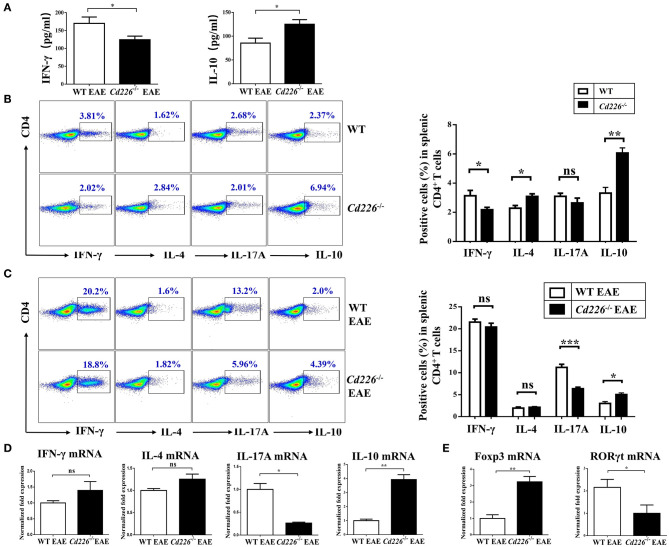
Lower levels of Th17 cells and higher levels of Tregs were observed in the spleen of Cd226−/− EAE mice. (A) The plasma levels of IFN-γ and IL-10 in Cd226−/− and WT mice during EAE pathogenesis were assessed by ELISA (n = 8). (B) Protein expression of IFN-γ, IL-4, IL-17A and IL-10 in sorted CD4+ T cells from splenocytes in Cd226−/− mice and WT littermates was assessed by intracellular staining. The numbers in each quadrant show the percentage of the relevant cell population (n = 8). (C) Splenocytes were stimulated in vitro with PMA (phorbol myristate acetate), ionomycin and brefeldin A in 10% FBS/RPMI 1,640 for 6 h. FCM data analysis of CD4+ T cell subsets for cytokines released from the spleens of Cd226−/− or WT mice was conducted on days 15–18 after immunization with MOG35−55 (gated on total CD4+ T cells, with frequencies on the left). The proportions of Th1, Th2, Th17 cells and Tregs were determined by intracellular cytokine staining (n = 6). (D) The relative mRNA levels of IFN-γ, IL-4, IL-17A, and IL-10 in CD4+ T cells isolated from the spleens of Cd226−/− or WT mice at days 15–18 after immunization with MOG35−55 were determined by RT-qPCR (n = 6). (E) The relative mRNA levels of Foxp3 and RORγt in CD4+ T cells isolated from the splenocytes of WT or Cd226−/− mice on days 15–18 after immunization with MOG35−55 were determined by RT-qPCR (n = 6). The results represent at least three independent experiments (A–E). The data are presented as the mean ± SEM. nsP > 0.05, *P < 0.05, **P < 0.005, ***P < 0.001.